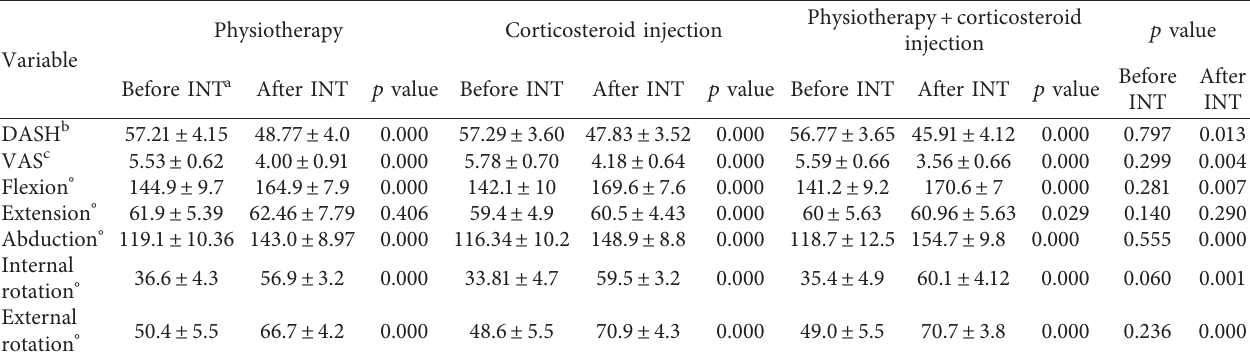
Table 2: The effect of different management on pain-related scores and range of motions. Variable Before INT a After INT p value Before